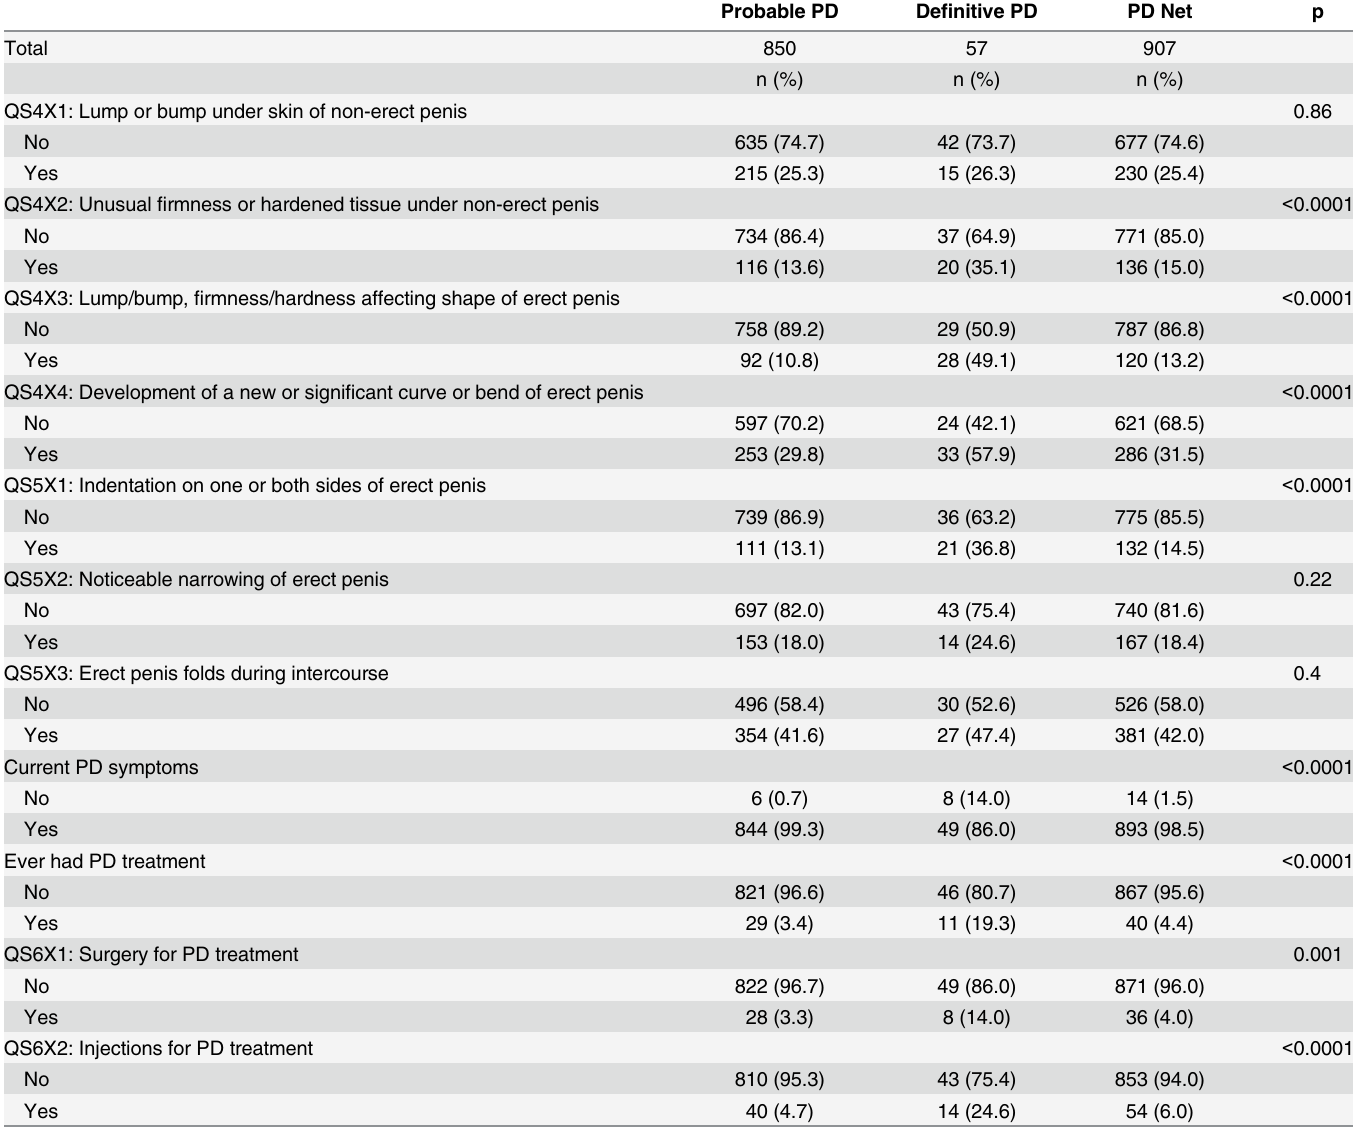
Table 4. Symptoms and